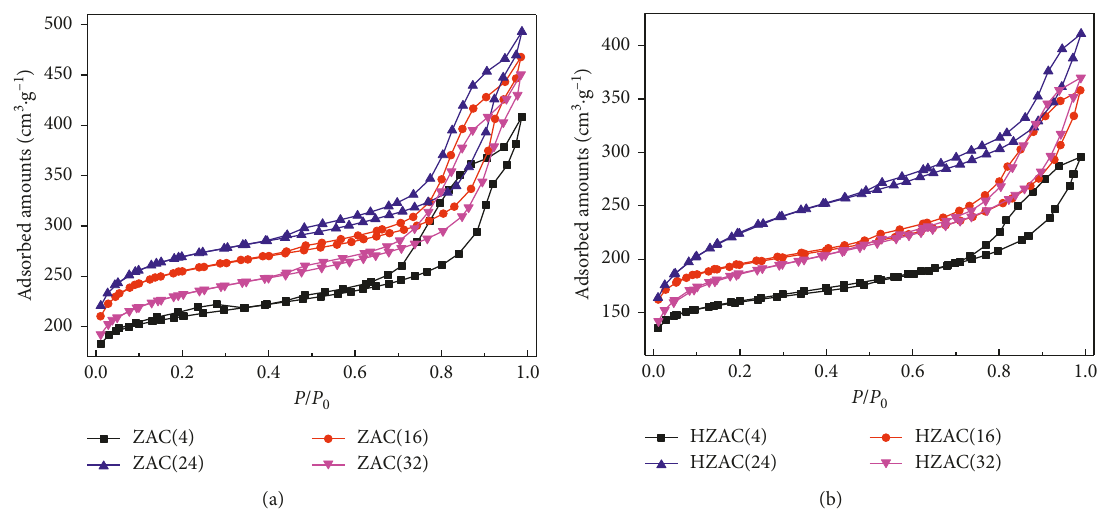
Figure 1: XRD patterns of ZAC( t